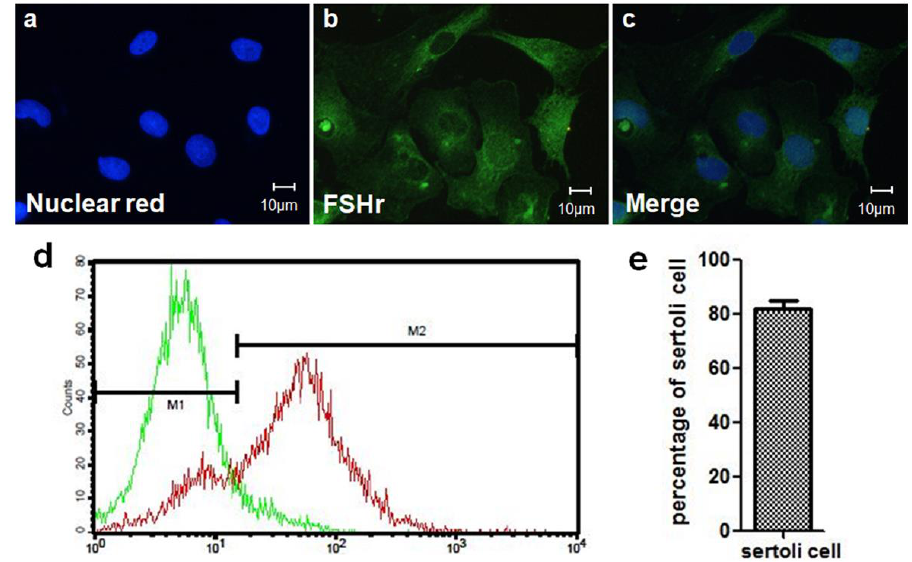
Figure 2. Isolation of Sertoli cells (SCs). IHC staining was used to identify SCs isolated from the testis. Staining included ( a ) nuclear red staining (biomarker of nucleus) and ( b ) immunostaining for FSHr (biomarker of SCs). ( c ) SCs were identified as double-labeled cells. ( d ) Flow cytometry showed different fluorescence intensity in M1 (cell suspension only stained with florescent secondary antibody) and M2 (cell suspension stained with FSHr primary antibody and florescent secondary antibody). The SCs (M2) exhibited a tremendously shifted peak as compared to the control (M1). ( e ) The purity of the SCs was calculated by flow cytometry.